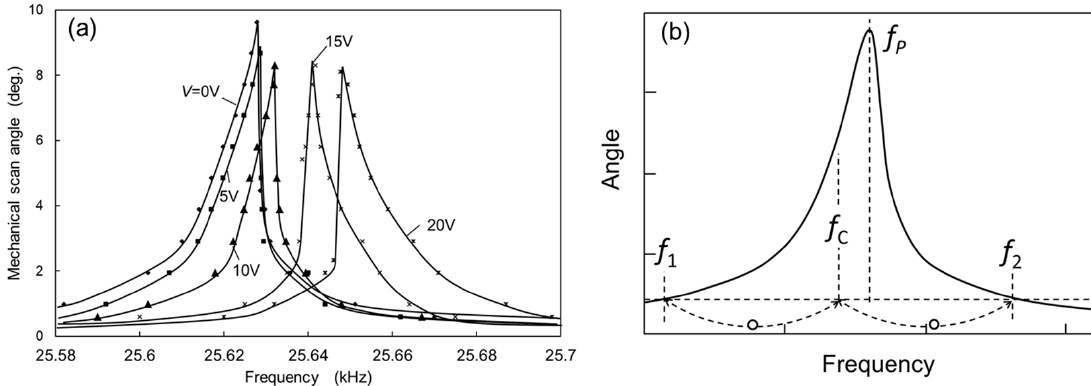
Figure 8. ( a ) Mechanical scan angle measured as a function of the frequency with the voltage V applied to the compensation combs as a parameter; and ( b ) the frequencies for obtaining the value of R S